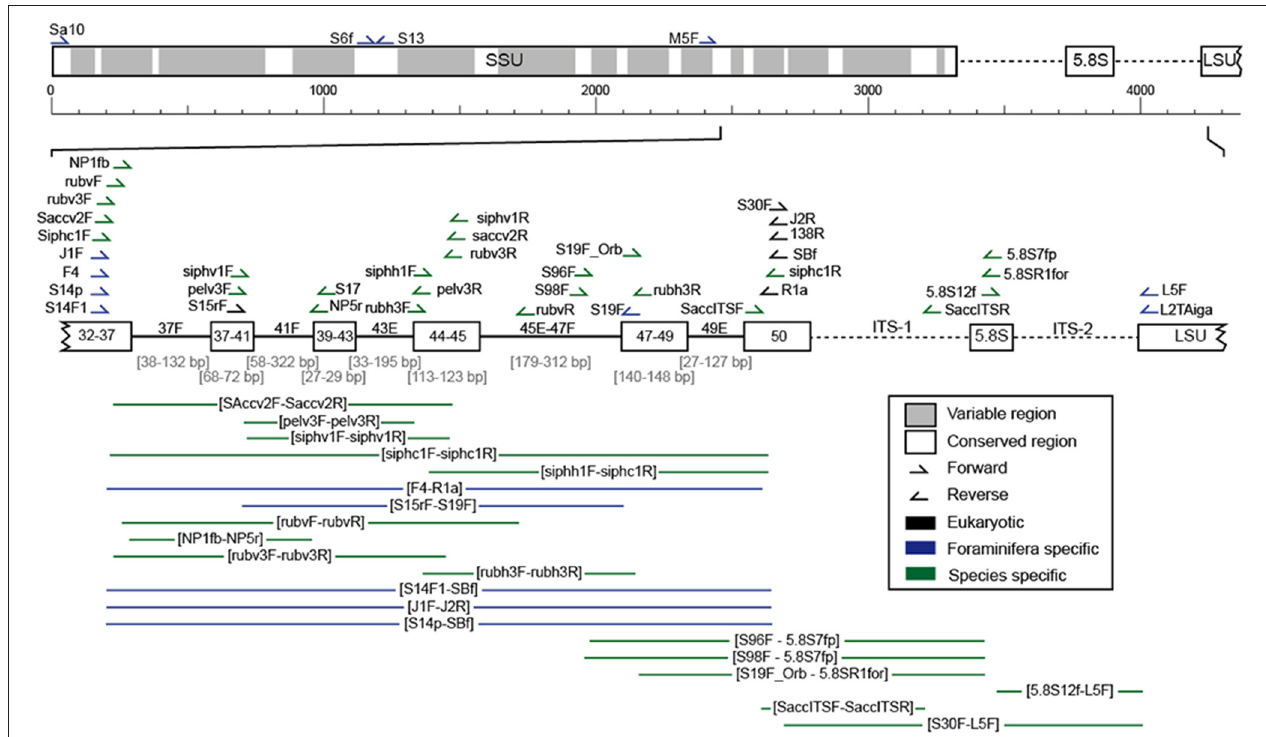
FIGURE 4 | Scheme of the ribosomal DNA with its variable (gray) and conserved (white) regions. The fragment mostly analyzed in planktonic foraminifera, located at the 3 ′ end of the SSU up to the ITS regions, is shown in more detail (variable regions as lines and conserved regions as boxes) and includes the position of all primer pairs used for the amplification of planktonic foraminiferal rDNA in the here evaluated studies (Supplementary Table